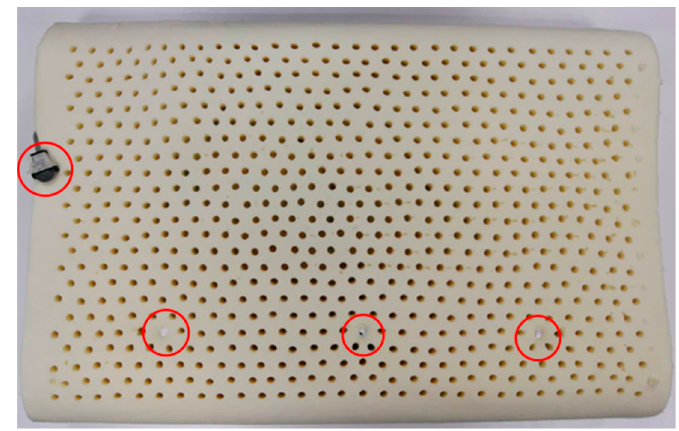
Figure 10. Prototype of experimental trial pillow.